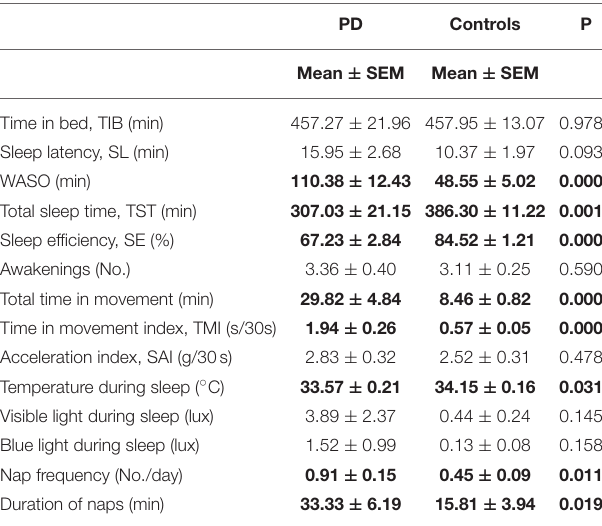
TABLE 4 | Main sleep